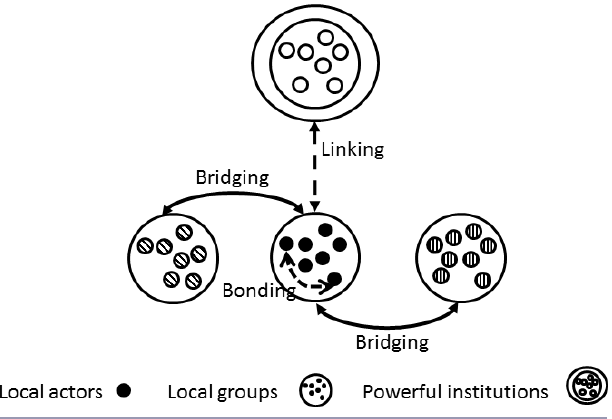
Fig. 1 . Illustration of the interactions within a group of people in an area (bonding social capital), horizontally among groups (bridging social capital), and vertically (linking social